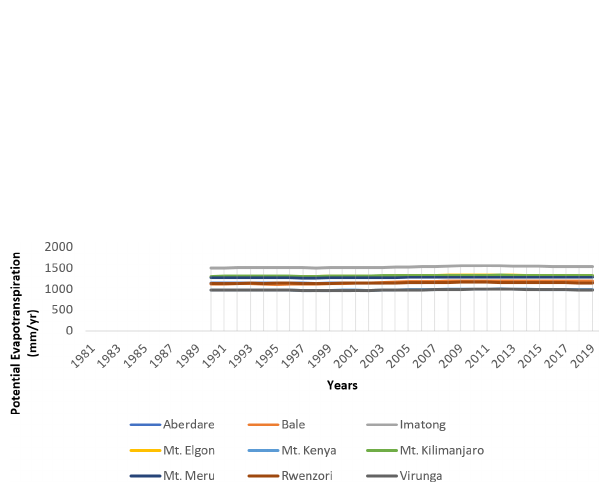
Figure A2. The 10-year moving averages of mean annual mean pre- cipitation at the different water towers.